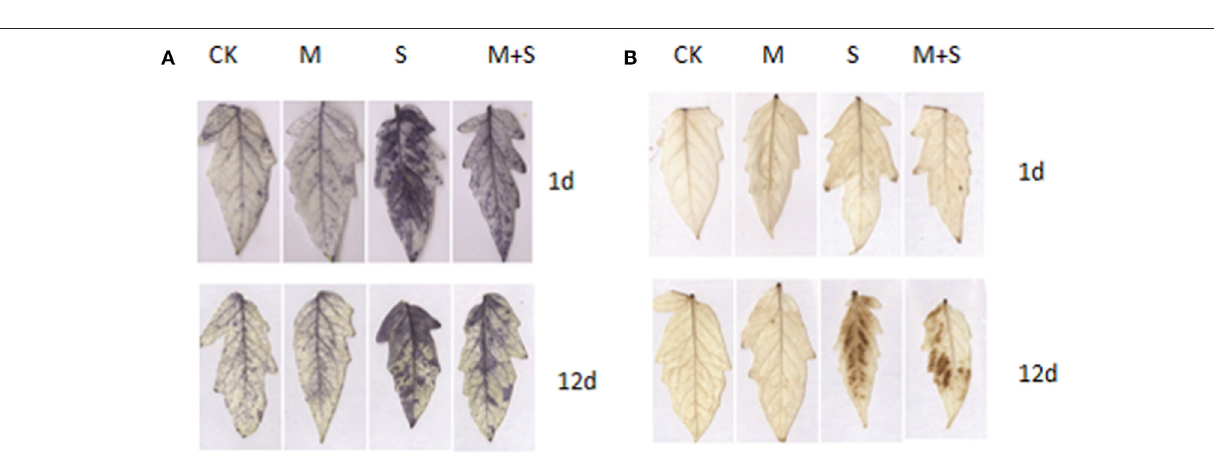
FIGURE 4 | Exogenous melatonin effects on levels of reactive oxygen species (ROS). CK, control; S, 150 mM NaCl; M + S, 150 µ M melatonin with 150 mM NaCl. (A) Histochemical localization of O −· 2 by NBT staining after 1 day (top) and 12 days (bottom) of salt treatment; (B) Histochemical localization of H 2 O 2 by DAB staining after 1 day (top) and 12 days (bottom) of salt treatment. CK, control; M, 150 µ M melatonin; S, 150 mM NaCl; M + S, 150 µ M melatonin with 150 mM